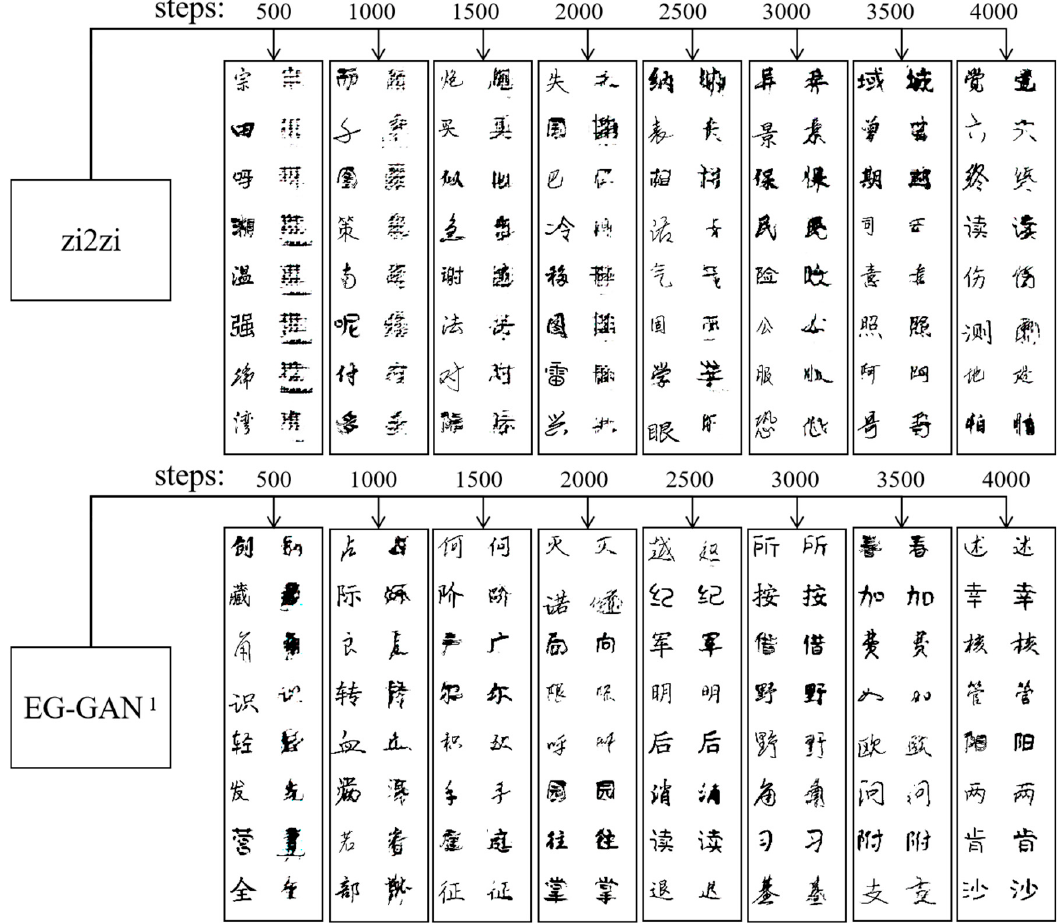
Figure 10. The comparison of EG-GAN 1 with Zi2Zi in the training process.